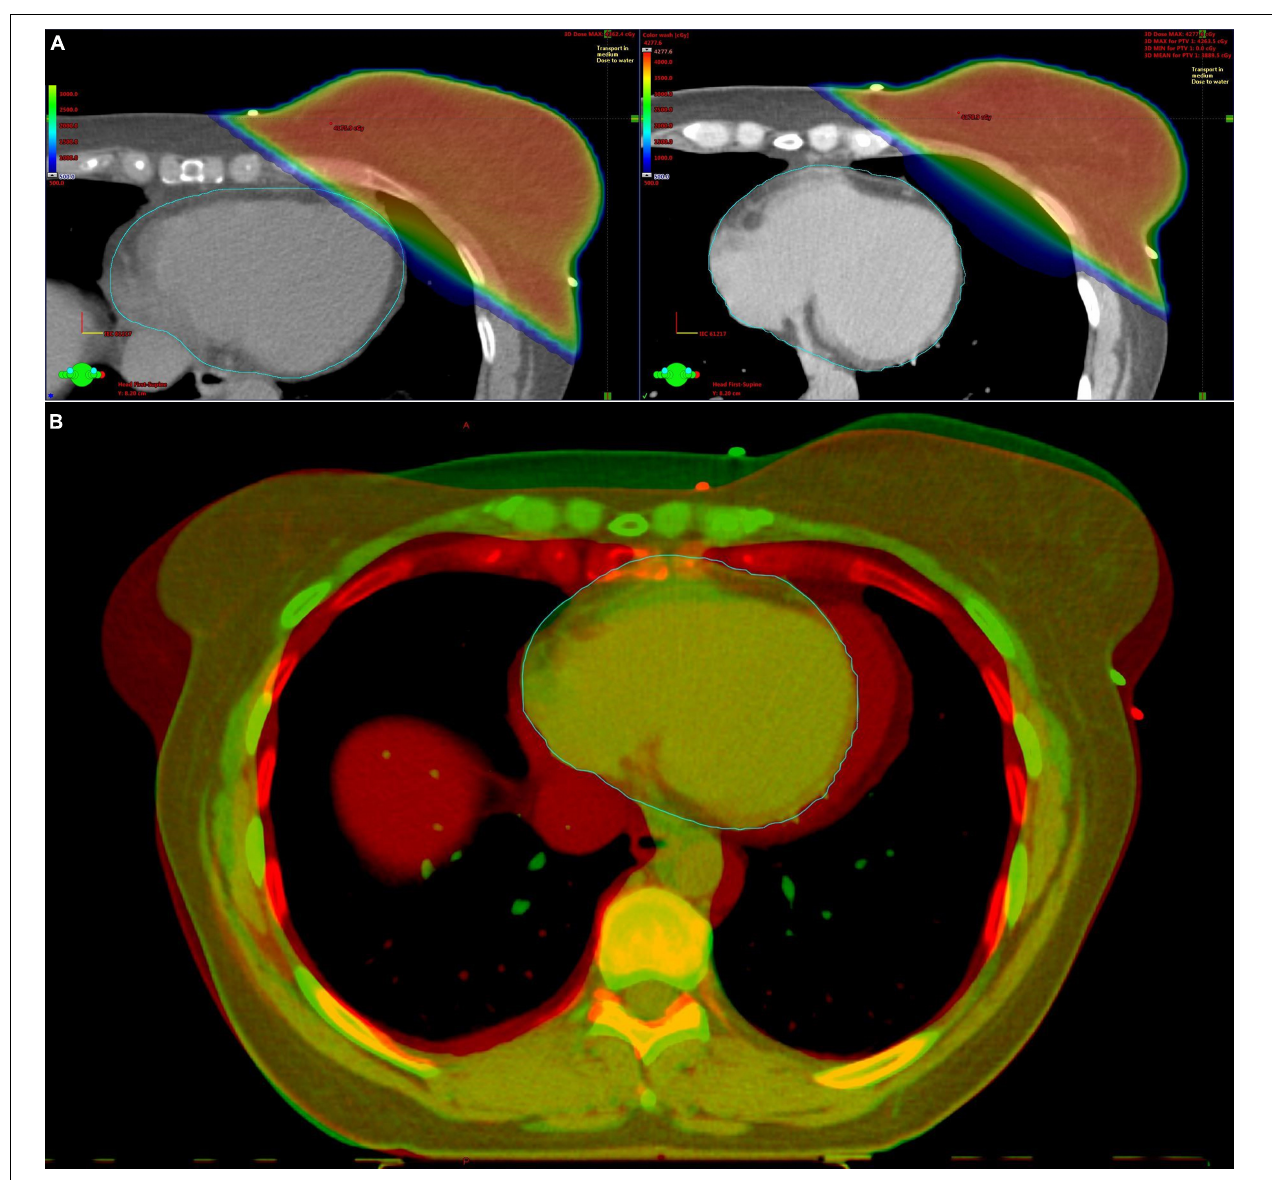
FIGURE 1 | Deep inspiration breath hold (DIBH) radiotherapy for left-sided breast cancer. (A) Axial computed tomography slices with radiotherapy plan at the same level of the breast in free breathing (left) and DIBH (right). The distance between the heart and the breast is greater in DIBH, minimizing the radiation of the heart. (B) Fusion image of the free breathing (red color) and DIBH (green color) computed tomography scan.